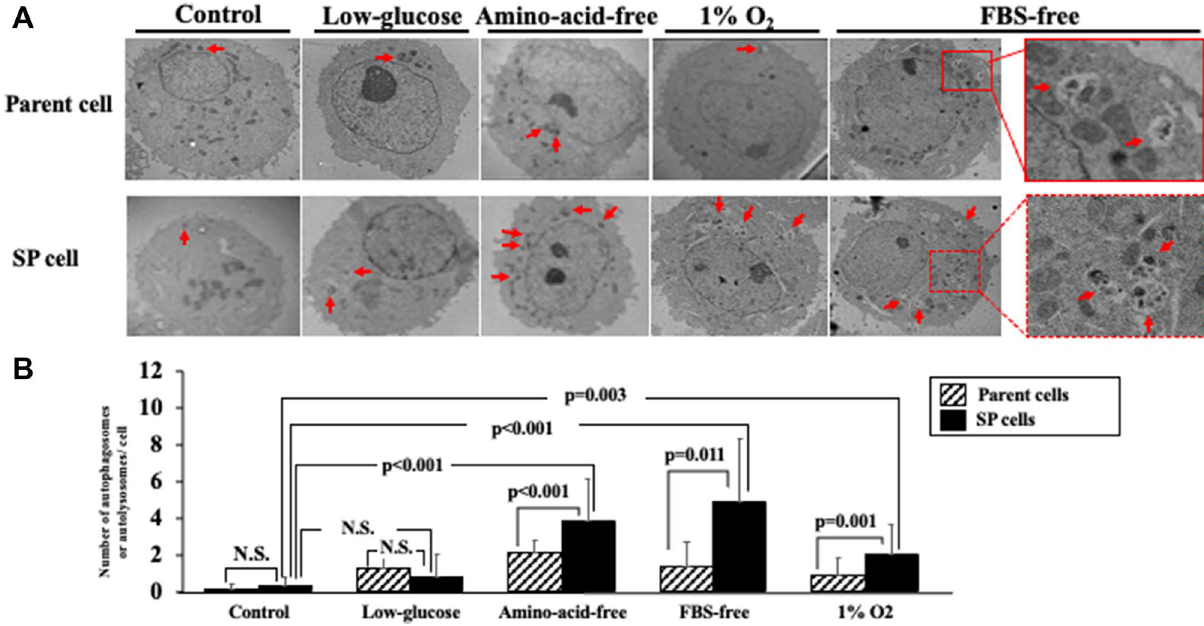
Figure 7. Molecular structure of autophagy in OCUM-12 cells . ( A ) Electron microscopic pictures of autophagosomes and autolysosomes. Arrows, autolysosomes or autophagosomes. ( B ) There was no significant difference between the OCUM-12/SP cells and the parent OCUM-12 cells in the control medium and low- glucose medium, but a significant increase in the number of autophagosomes and autolysosomes in the OCUM- 12/ SP cells was observed under the Amino-acid-free medium (p < 0.001), FBS-free medium (p = 0.011), 1% O 2 (p = 0.001).